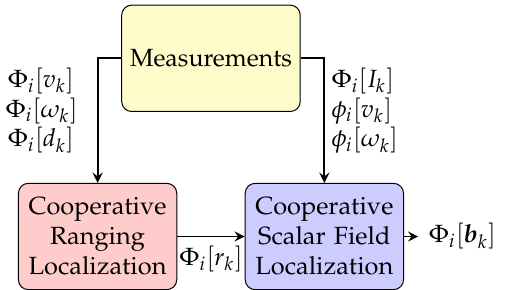
Figure 3. The pipeline of the cooperative localization process in a subgroup i . Φ i [ r k ] means the relative poses between each pair of agents in the subgroup i at time step k